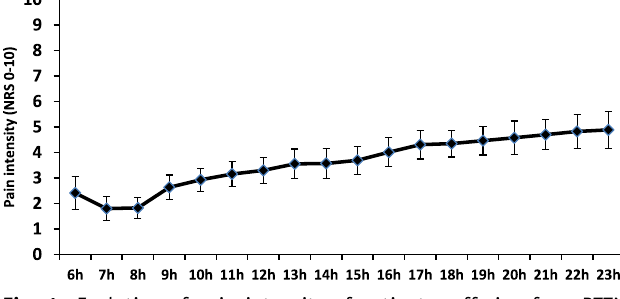
Fig. 1. Evolution of pain intensity of patients suffering from PTTN ( n =11). Mean pain intensity (M±SEM) auto-evaluated using a numerical rating scale (NRS) from 0 to 10 is reported every hour during waking period. The curve represents the mean value of all patients measured over 8 consecutive days. Noteworthy is the quasi-linear increase in pain intensity throughout